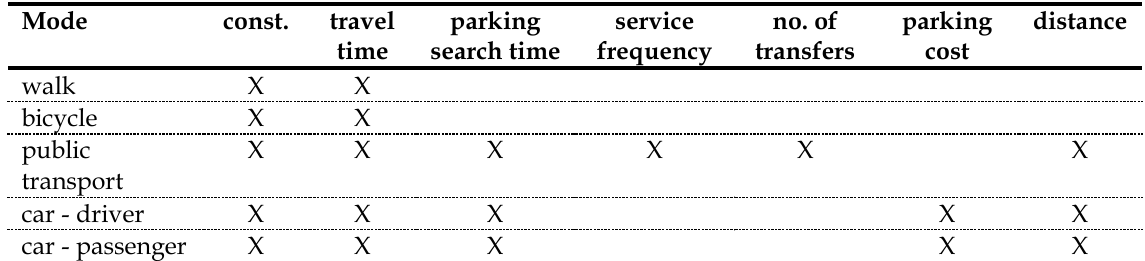
Level of service measures used in mode choice utility Mode const. travel parking service no. of parking time search time frequency transfers cost